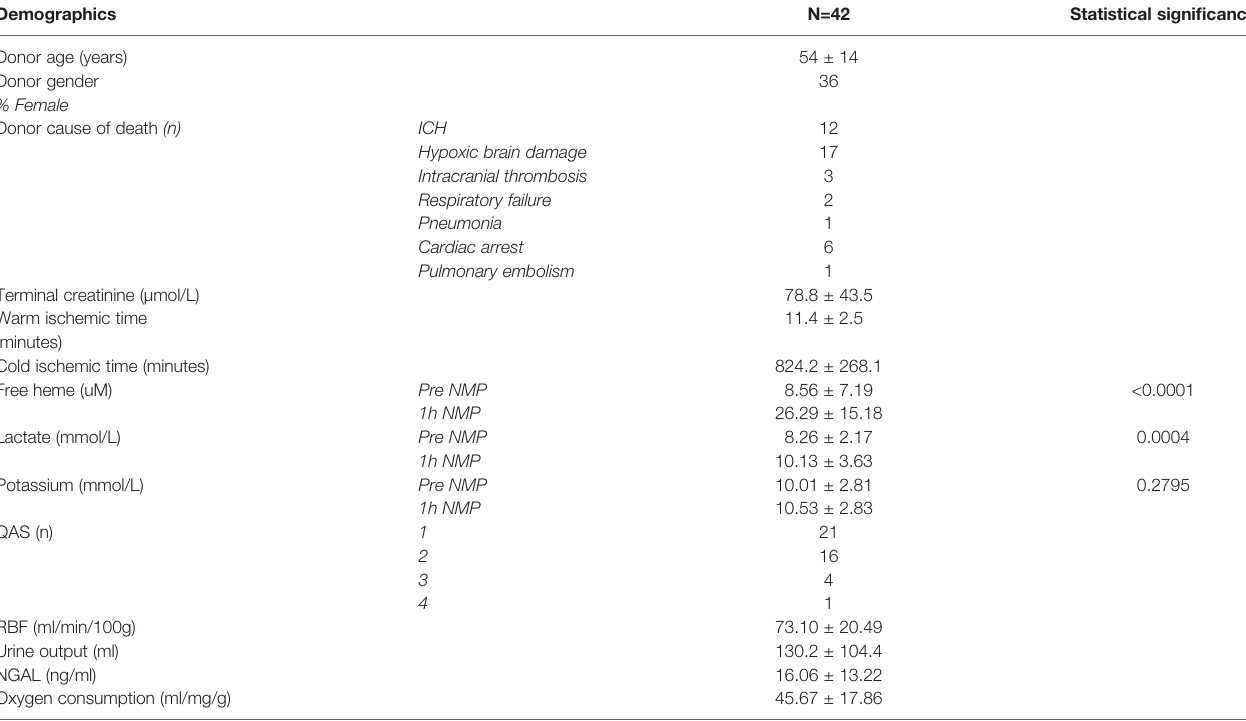
TABLE 1 | Donor demographics and perfusion outcomes (n=42) of DCD kidneys that underwent 1h NMP prior to transplantation.